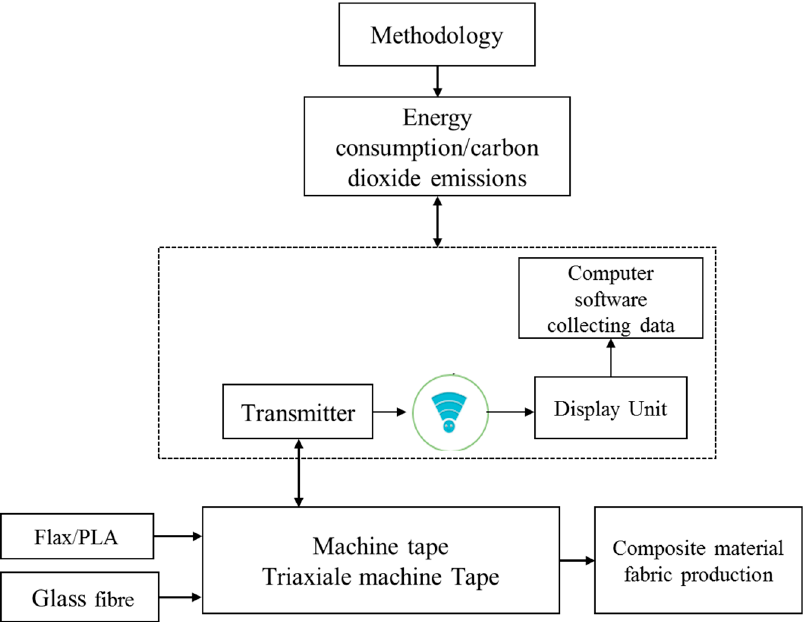
Figure 2. Gate-to-gate (GtG) based on data collection on the production process stage of Flax/PLA.